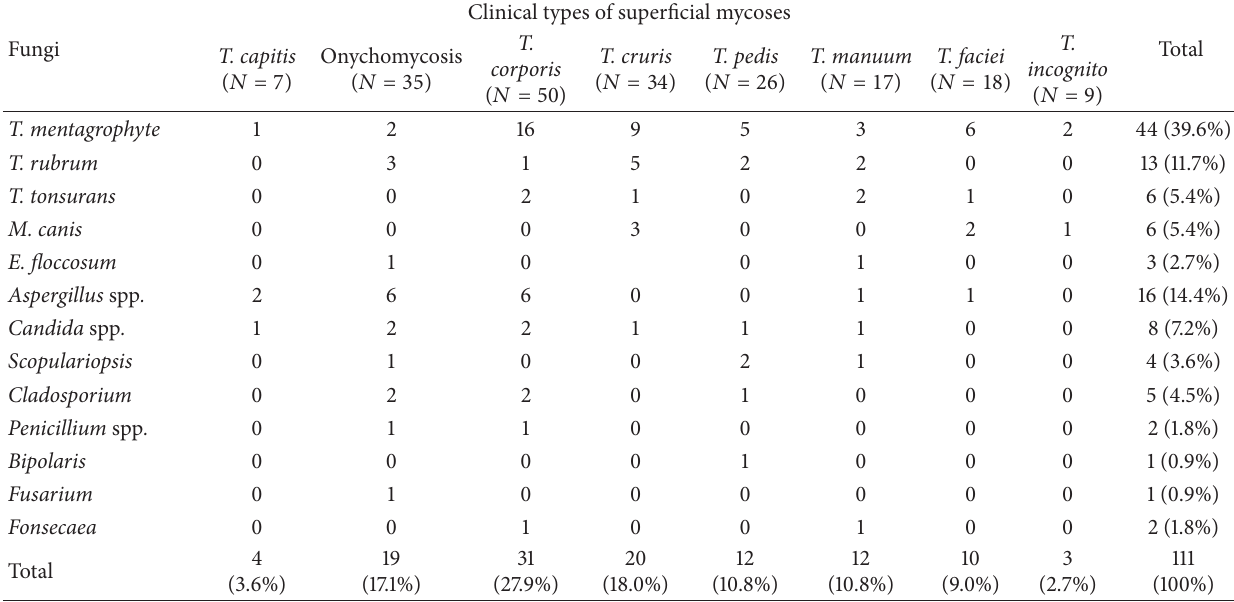
Table 3: Clinicomycological characterization of superficial mycoses.